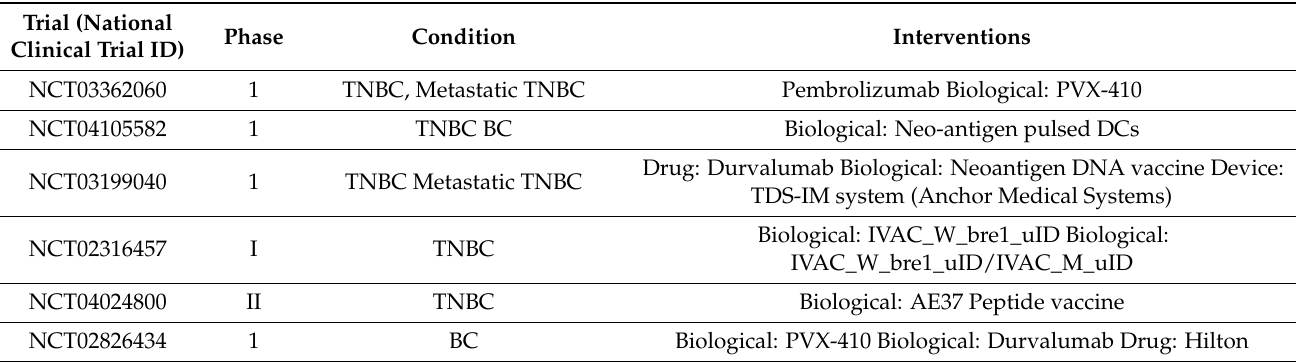
Table 3. List of all clinical trials with exosomes loaded with drugs in triple-negative breast can- cer